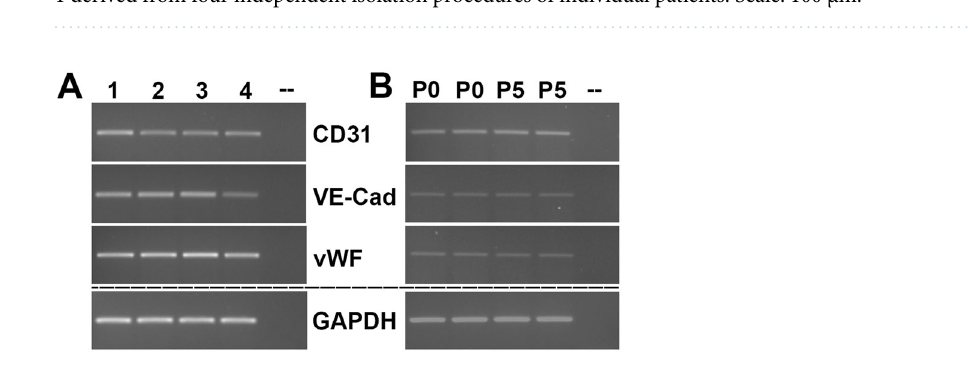
Figure 3. Immunocytochemical staining of endothelial cell marker proteins verified the endothelial origin of the ECs. Immunoreactivity against CD31 ( A ) as well as VE-cadherin ( B ) was detected at cell–cell contacts (arrowheads), while N-cadherin ( C ) showed a diffuse somatic staining of varying degree with weak accumulations at junctional contacts (arrowheads). The ZO-1 immunoreactivity ( D ) was found at cell–cell contacts labeling cellular junctions (arrowheads). These results were reproduced four times with ECs at passage 1 derived from four independent isolation procedures of individual patients. Scale: 100 µm.